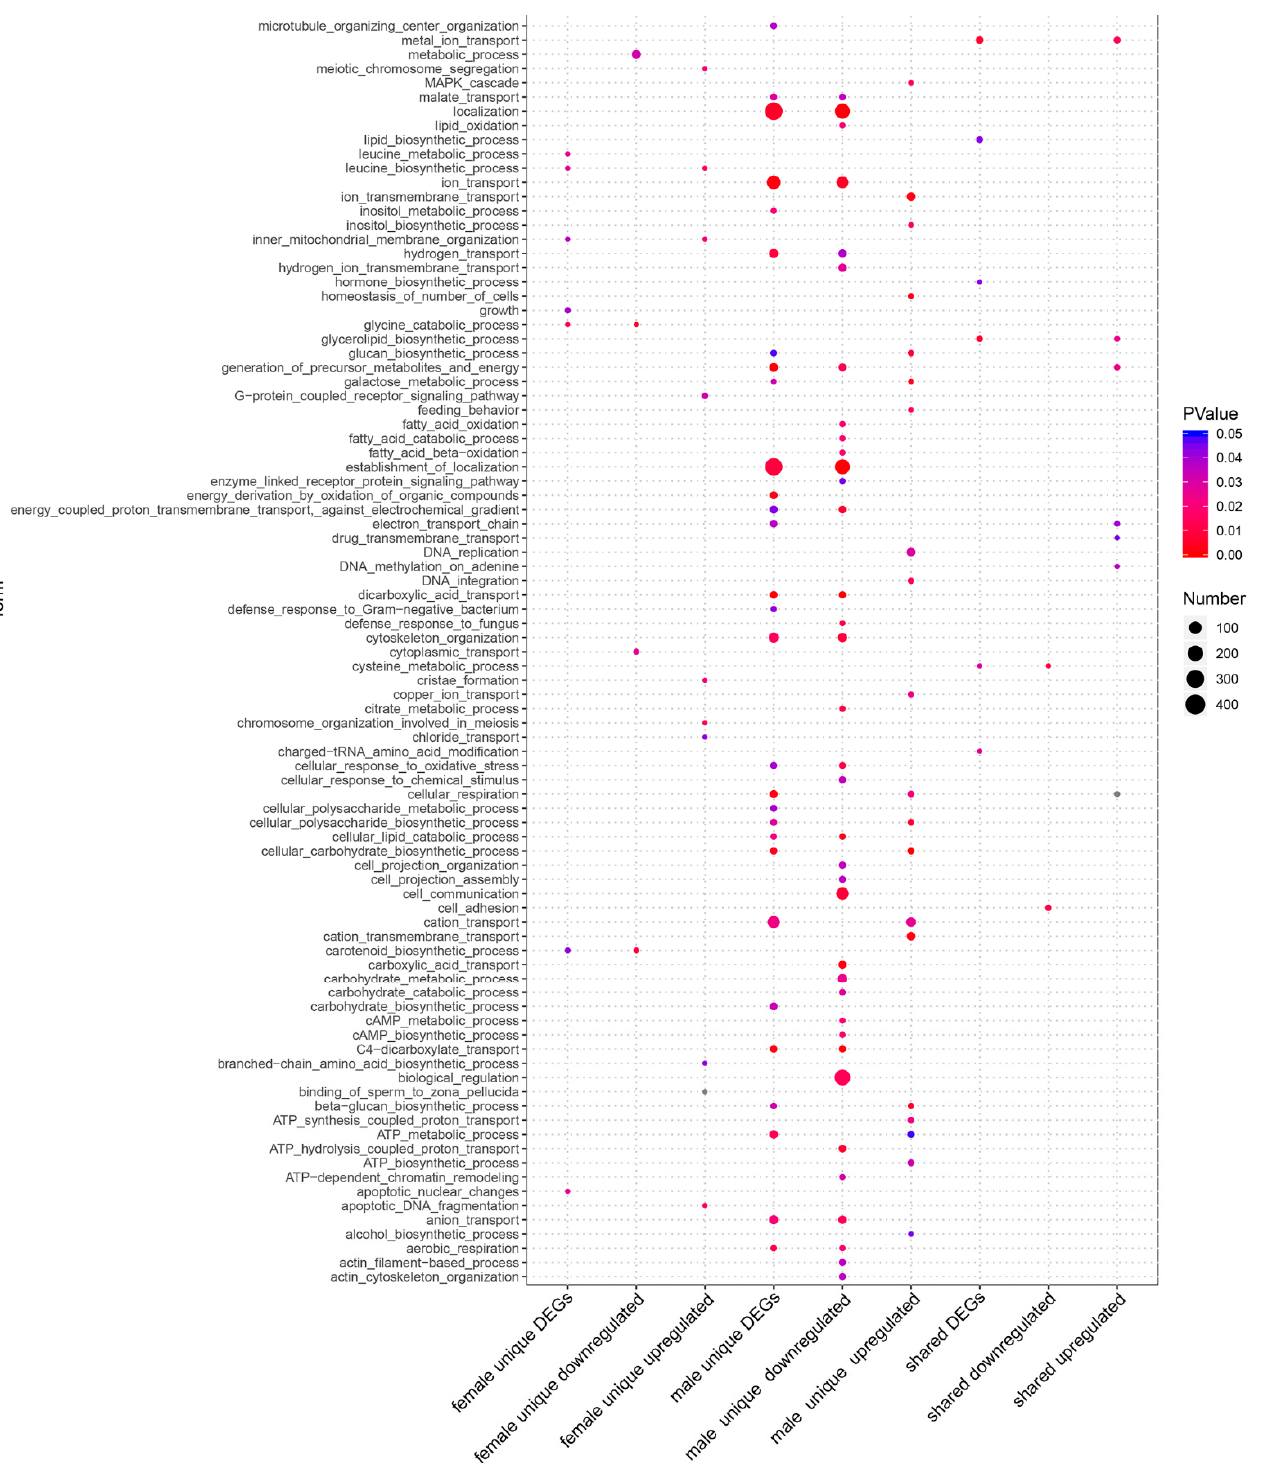
groups of DEGs (control: male, treatment: female): Cera − unique downregulated genes, Cera − unique upregulated genes, Cera − unique DEGs, Cera + unique downregulated genes,